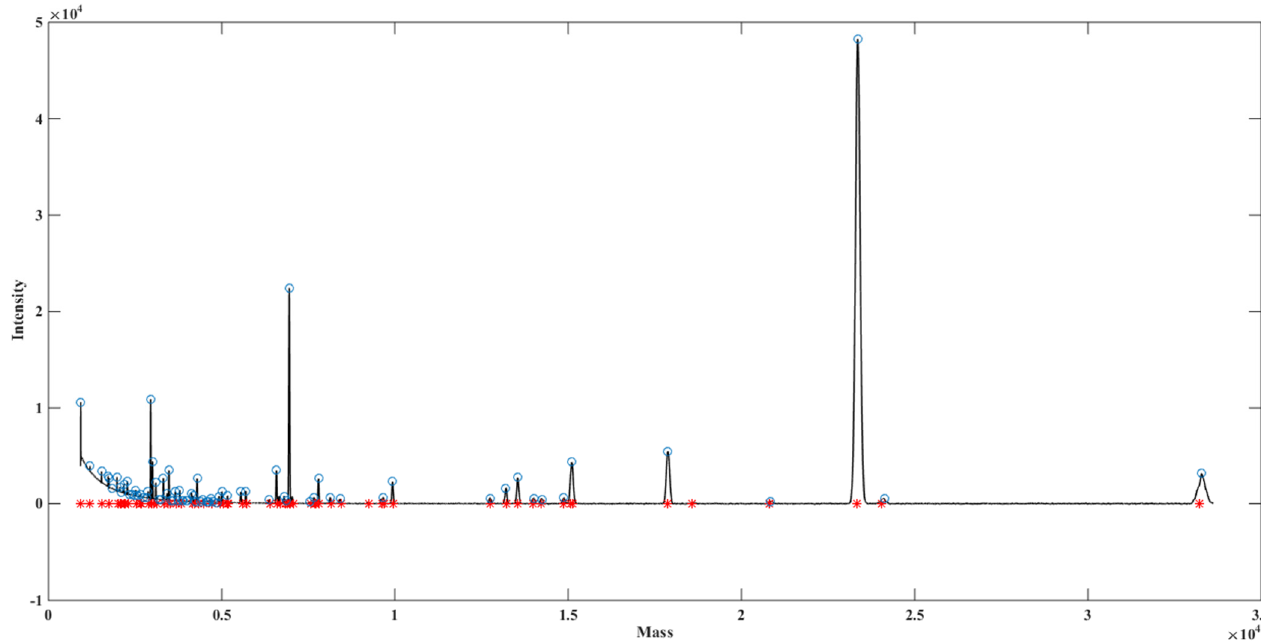
Figure 6. The comparison results of the peak points classified by the algorithm proposed in this paper and the real peak data of a publicly available dataset. The red * marks the real peaks in the database, and the blue circles mark the peaks identified by the algorithm in this paper.